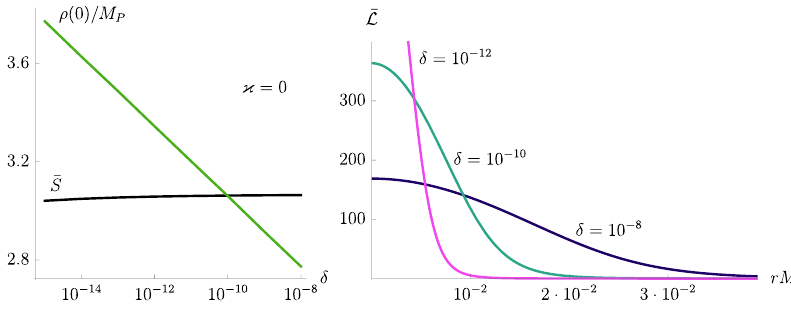
Figure 6 . The singular term (cid:26) (0) =M P and the instanton action (cid:22) S = R dr (cid:22) L , contributing to (cid:22) W according to eq. (4.51). Here we take { = 0 and (cid:24) 1 = 1, (cid:24) 2 = 1 : 1. The left panel shows the two contributions depending on the choice of (cid:14) . One sees that, although (cid:22) W is positive for (cid:14) & 10 (cid:0) 10 , it is impossible to achieve the regime when (cid:22) W (cid:29) 1. The right panel shows the instanton Lagrangian as a function of the radial coordinate and for di(cid:11)erent values of (cid:14) . An agreement with eqs. (4.42) and (4.54) is observed.